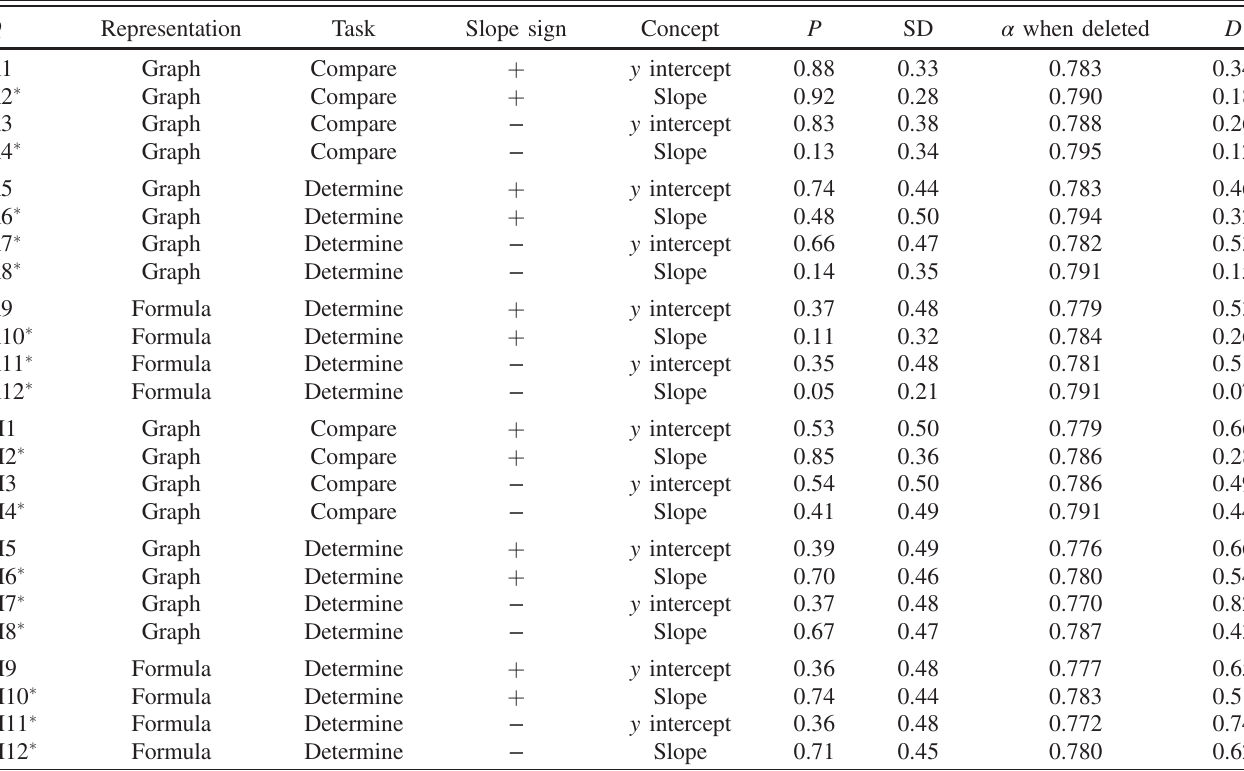
TABLE I. Validation results sorted by context (indicated by “ K ” for kinematics and “ M ” for mathematics in the question number Q ); by representation (graph or formula); by task (compare or determine), by slope sign ( “ þ ” for positive, “ − ” for negative) and by concept ( y intercept or slope). The statistical parameters are item difficulty index P and its standard deviation SD; Cronbach ’ s α when the item in question would be deleted; and item discrimination index D. Items marked with (cid:2) require the respondent to provide an explanation for their